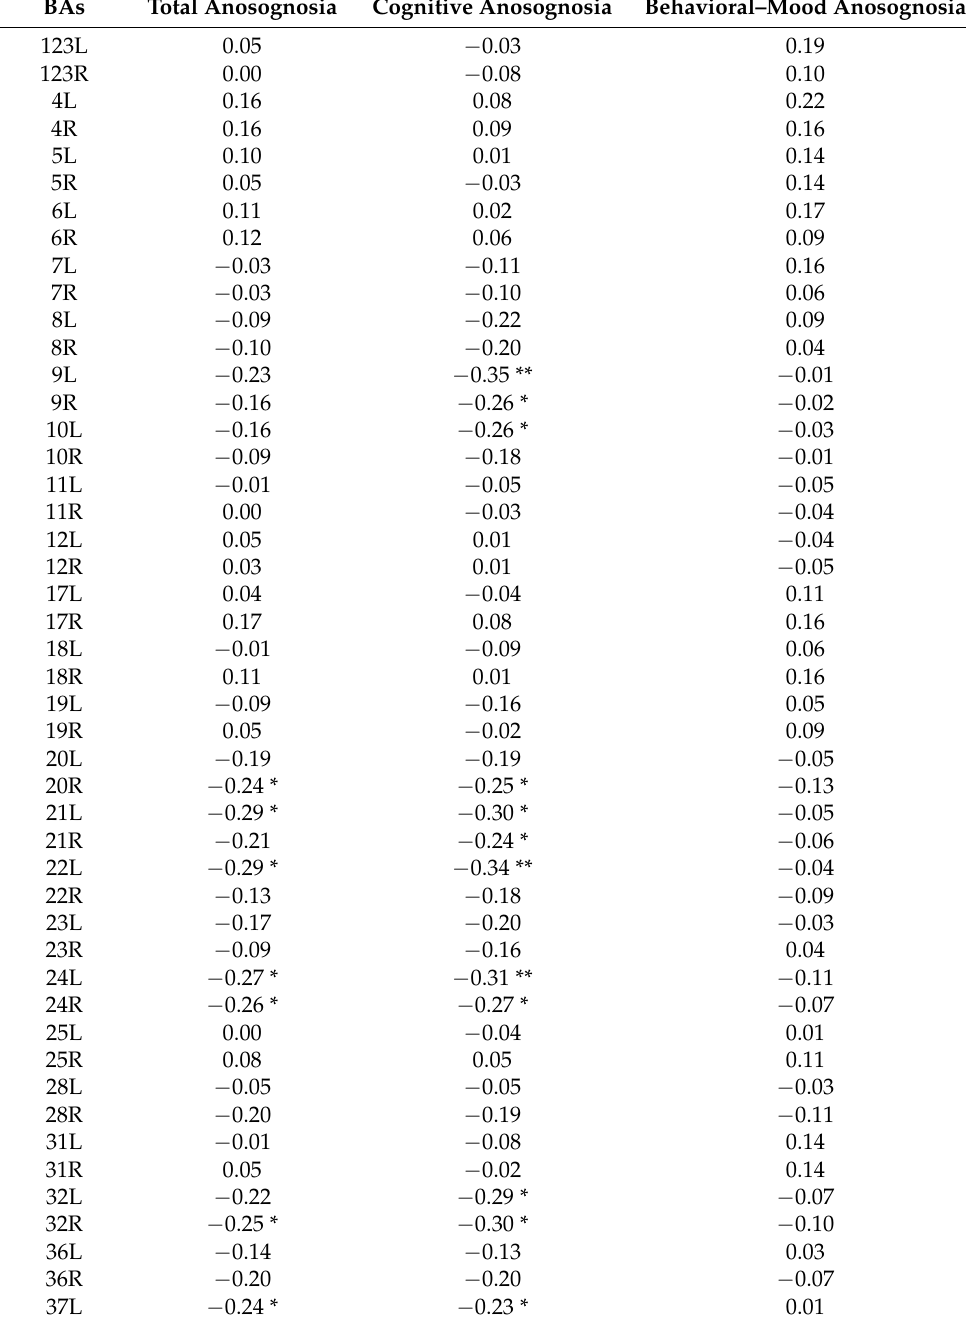
Table 3. Spearman’s correlation coefficients of anosognosia scores with BA perfusion after comparison with normal database. BAs Total Anosognosia Cognitive Anosognosia Behavioral–Mood